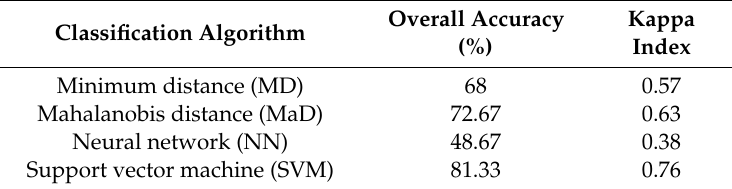
Table 4. The accuracy assessment of supervised classification